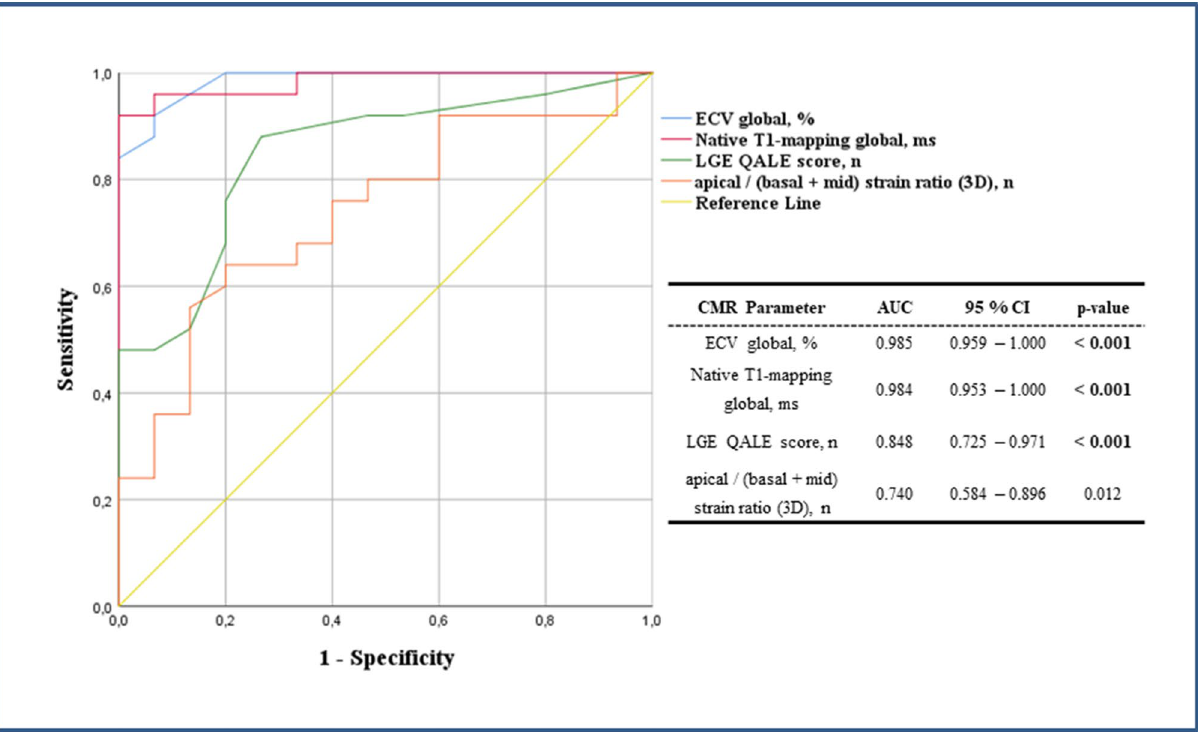
Figure 2. Receiver operating characteristic curve illustrating the diagnostic yield of the following parameters: i) extracellular volume fraction (ECV) global (light blue), (ii) T1-mapping global (red), (iii) Query Amyloid Late Enhancement (QALE) score (green), (iv) “apical-to-(basal + midventricular)”-ratio of left ventricular longitudinal strain (orange), in the distinction of cardiac amyloidosis (CA) from hypertrophic cardiomyopathy (HCM).